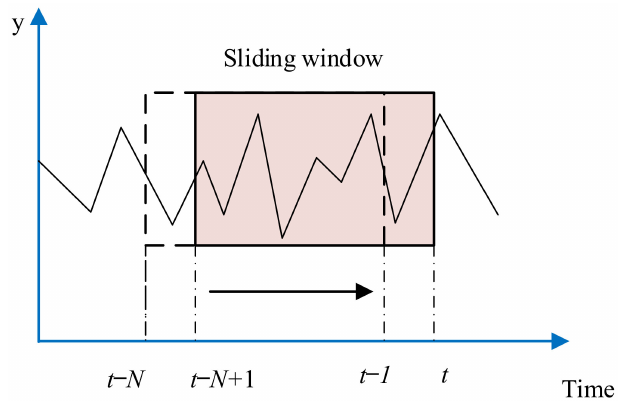
Figure 1. Sliding